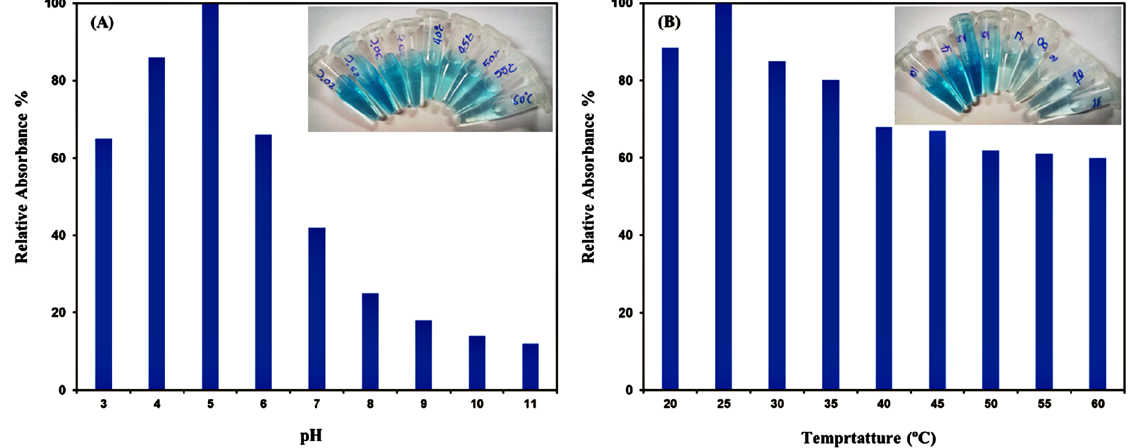
Figure 6. Effects of various pH ( A ) and temperatures ( B ) on the peroxidase-mimicking activity of the nanoplatform.